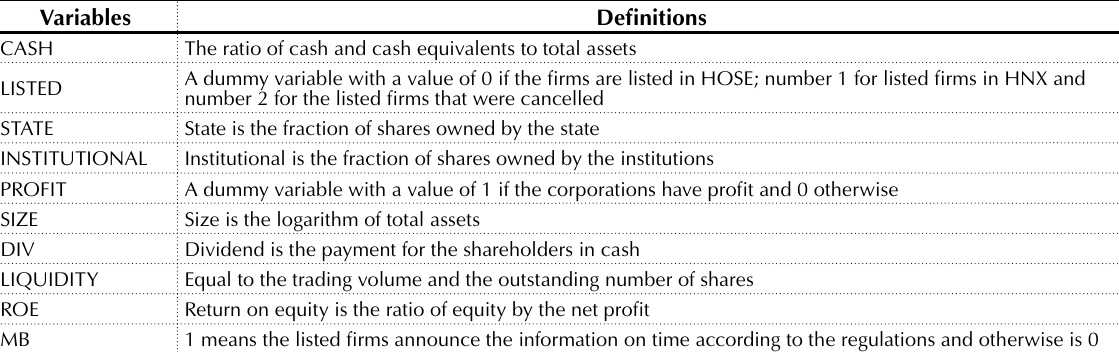
Table 2. Summary of all